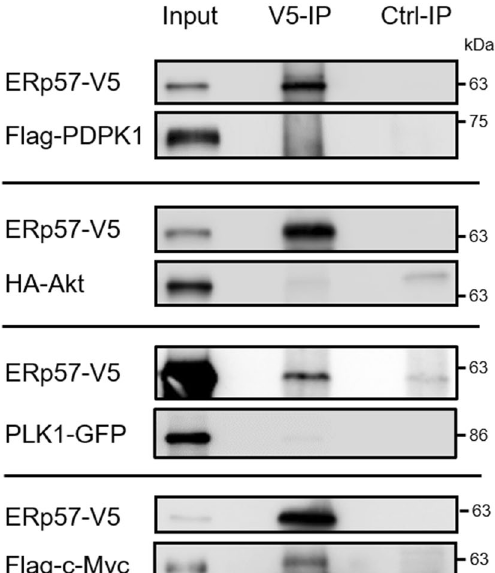
Figure 6. Analysis of protein–protein interaction for ERp57 with PDPK1, AKT, PLK1 and c-Myc. Plasmid pe-N1-ERp57-V5 was co-transfected with vectors CMV-3xFlag-hPDPK1, pCDNA3-HA-AKT1, pEYFP- PLK1 or pCMV4a-Flag-c-Myc into HEK293T cells. For all IP experiments, ERp57 was pulled with an anti-V5 antibody (V5-IP) and complex formation with PDPK1, AKT, PLK1 and c-Myc was determined by western blot analysis using anti-FLAG, anti-HA, anti-GFP and anti-c-Myc antibodies, respectively. 1–3% of total cell lysate was loaded as